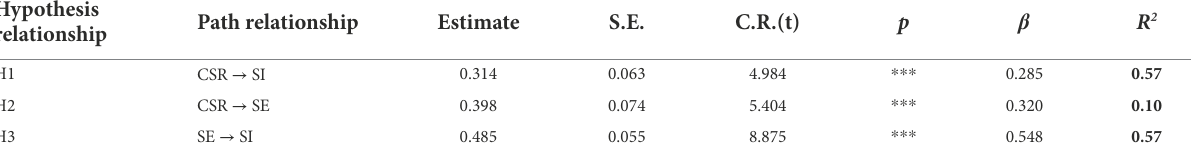
TABLE 7 Path parameters.